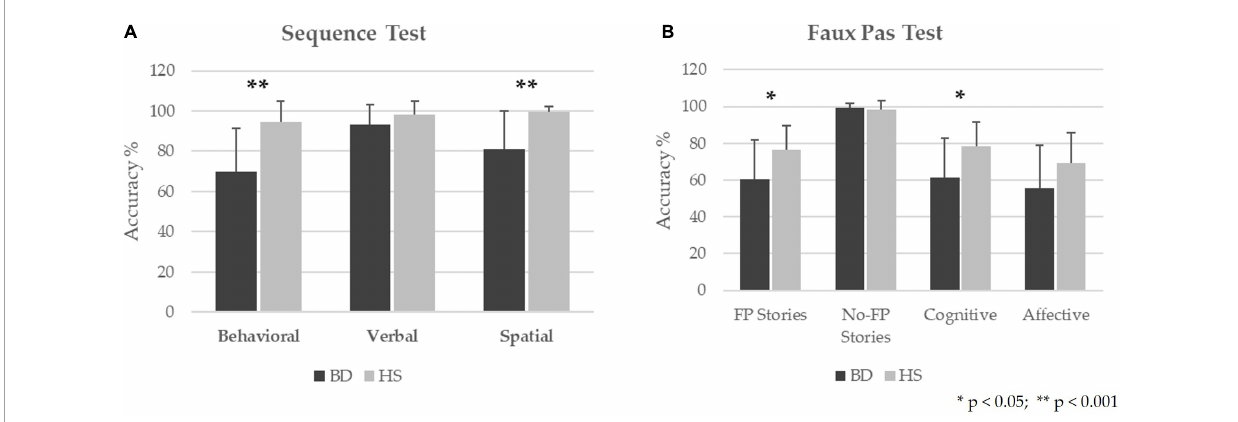
FIGURE1 Behavioral results in BD patients as compared to HS. The results for Sequence Test (A) and Faux Pas Test (B) are presented as the percentage of the total number of correct responses (accuracy); 0% indicates no correct answers, and 100% indicates totally correct answers. The mean and standard deviation of the accuracy are reported for BD and HS. ** Statistical significance at p -values < 0.001. *Statistical significance at p -values < 0.05.